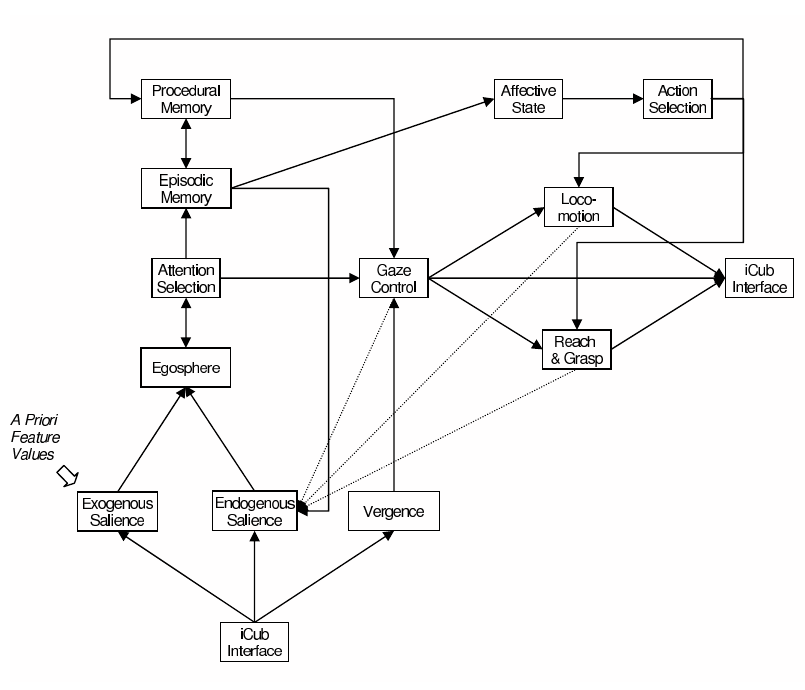
Figure 4. The iCub cognitive